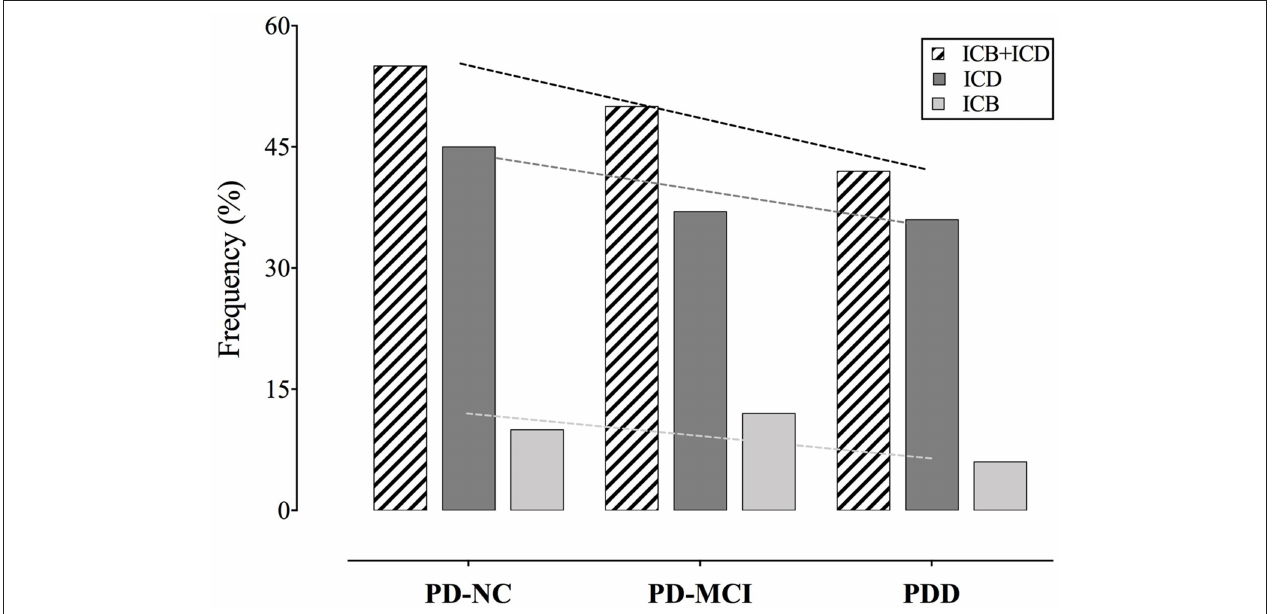
FIGURE 2 | Frequency of ICDs and ICBs among cognitive states. Slopes of the trend lines are reported. PD, Parkinson’s disease; PD-NC, PD with normal cognition; PD-MCI, PD with mild cognitive impairment; PDD, PD with dementia; ICD, impulse control disorder; ICB, impulsive compulsive behavior. TABLE 3 | Frequencies of patients with a failure in at least two tests within a cognitive domain across cognitive states and ICD-subgroups. Cognitive